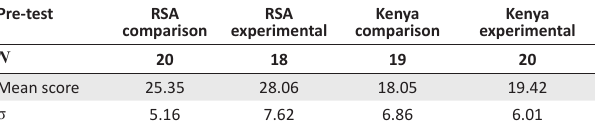
TABLE 2: South African and Kenyan pre-test number of participants, mean scores and standard deviations. Pre-test